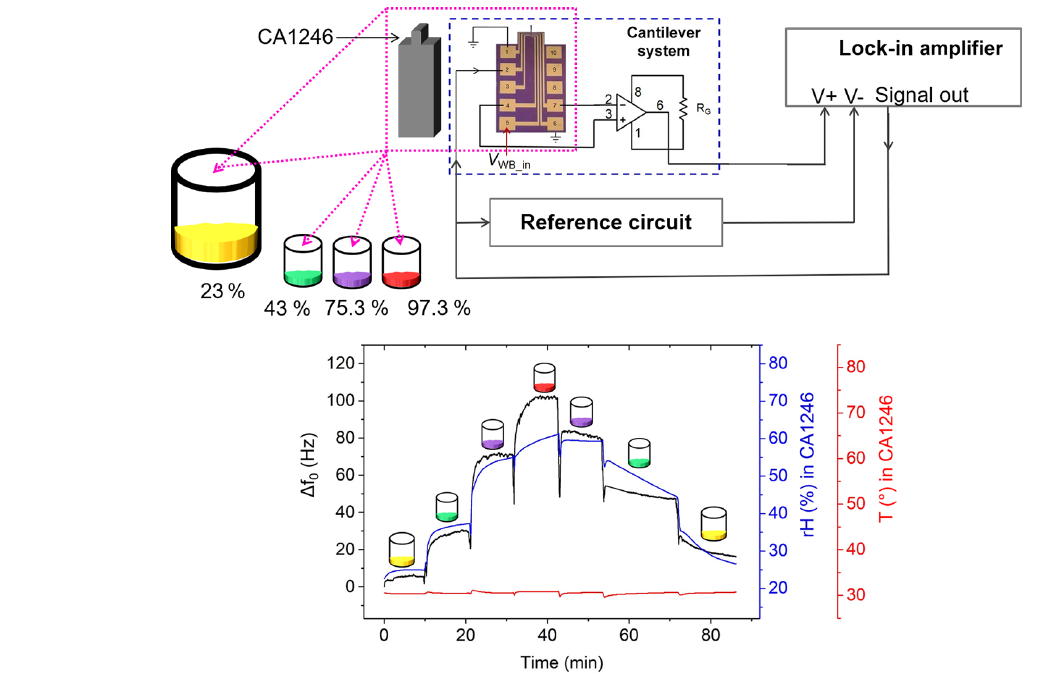
Figure 12. Resonant frequency shift ( (cid:49)f 0 ) of a piezoresistive silicon cantilever with a ZnO/chitosan sensing layer under a controlled environment of temperature and relative